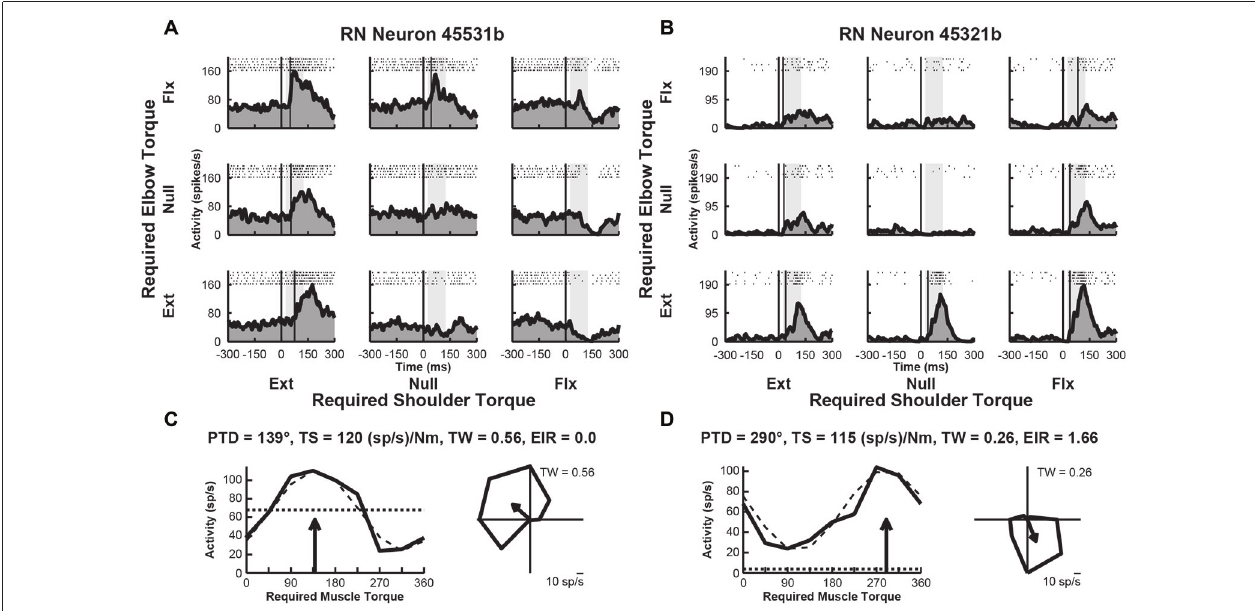
Directional tuning of the corresponding RN neurons. Left sub-panels illustrate linear plots of overall activity vs. joint-torque angle. Unloaded baseline activities and cosine fits are shown as dotted and dashed lines, respectively. Right sub-panels show polar plots of the perturbation-related activity (baseline removed) in joint-torque space. PTD, preferred-torque direction; TS, torque-slope; TW, tuning width; EIR, excitation-inhibition